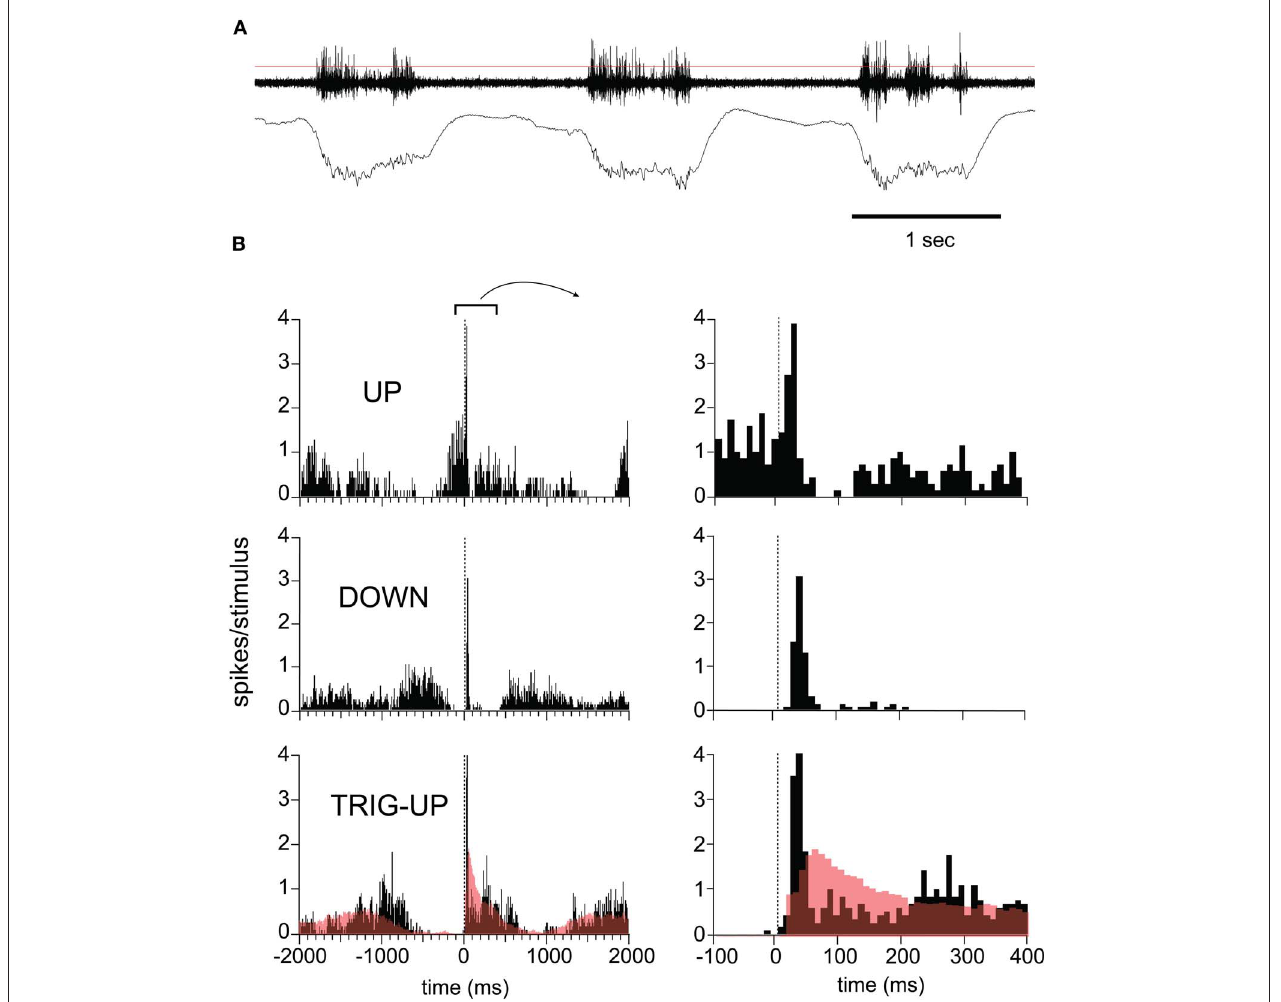
time with respect to the slow oscillation. Top: responses in up-state. Note inhibition revealed by trough in PSTH during up-state. Middle: Short-lasting responses in down-state. Bottom: Stimulus triggers up-state. Red line shows the histogram of spontaneous up-state, superimposed. All data is from same experiment shown in Figure 1